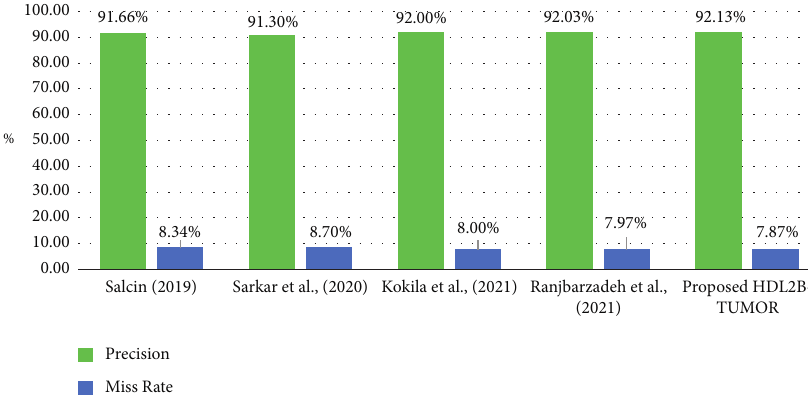
Figure 5: Comparison chart of literature with